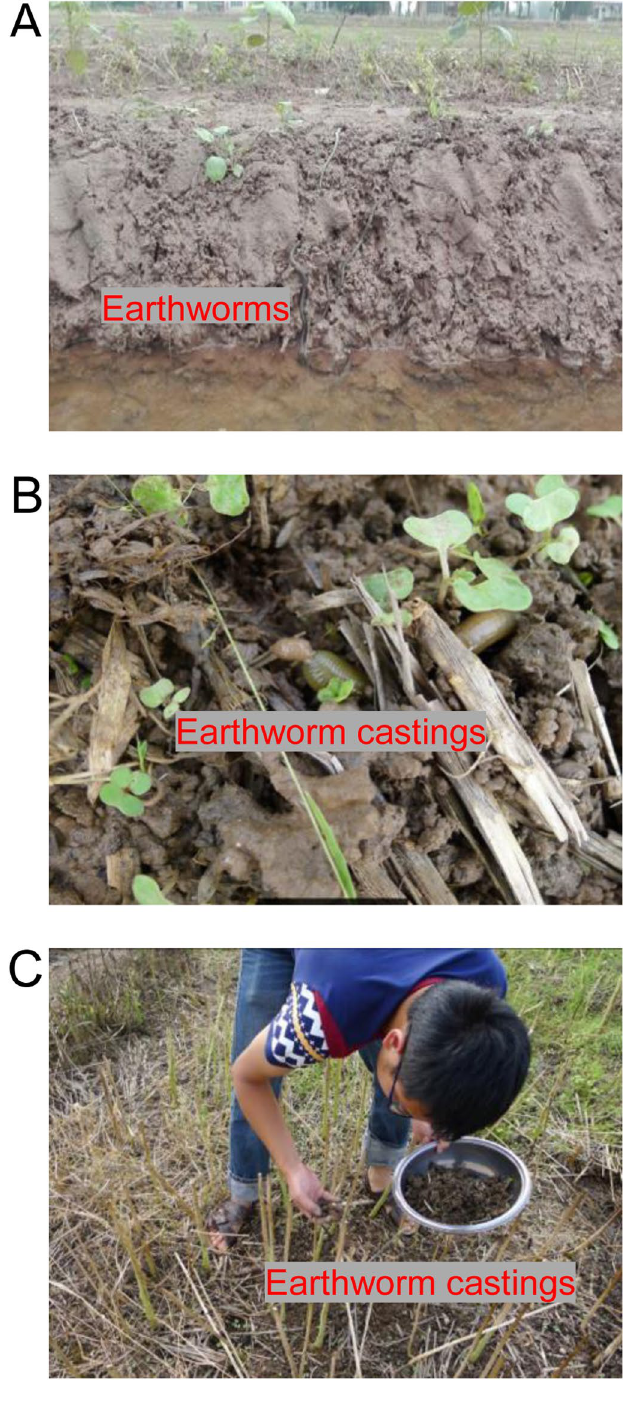
Figure 1. Earthworms migrated away from the rice field after flooding ( A ), earthworm castings produced in the oilseed rape-growing season ( B ), and earthworm castings collected after harvesting the oilseed rape ( C ). These photos were taken from rice-oilseed rape cropping fields located in Nanxian, Hunan Province, China in